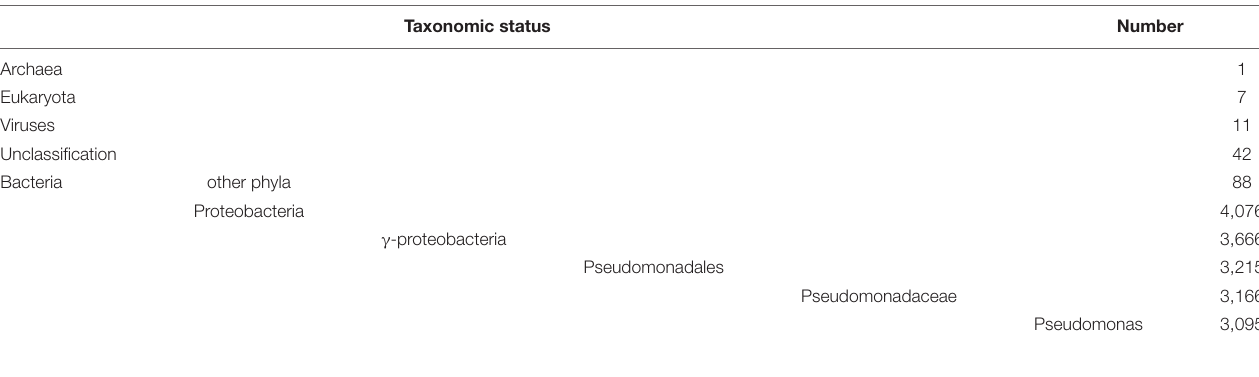
TABLE 2 | Taxonomic characterization of best blastp hits for cloud